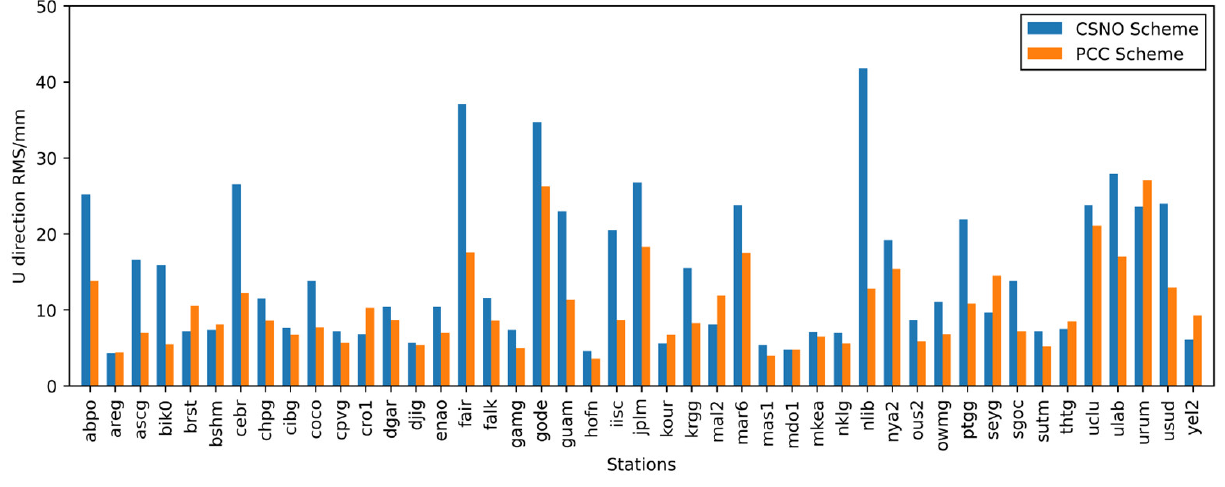
Figure 12. The time series of the differences of the CSNO Scheme IGSO orbit compared with the